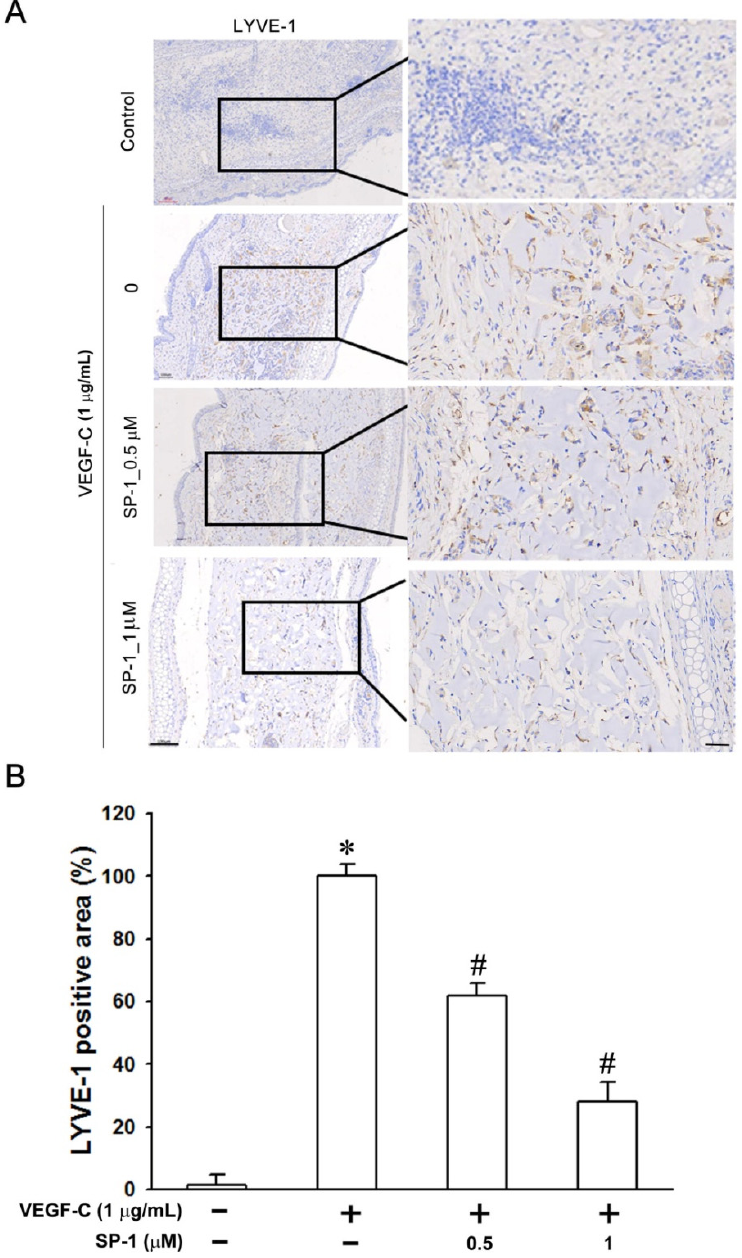
Figure 3. Heteronemin reduces the VEGF-C-stimulated lymphangiogenesis in mouse ear collagen sponges. Gelatin sponges were saturated with medium containing VEGF-C (1 μ g/mL; positive control) with or without indicated concentration of heteronemin (represented as SP-1). Sponges were implanted, for 3 weeks, between the two layers of skin in mice ears. ( A ) Lymphatic vasculatures in sponge sections were detected by LYVE-1 immunostainings (bars = 100 and 70 μ m higher magnification). ( B ) Quantification of the densities of lymphatic vessels (LYVE-1 positive area). Data are expressed as means ± SEM of five mice. * p < 0.05 versus medium sponges; # p < 0.05 versus VEGF-C-stimulated sponges.